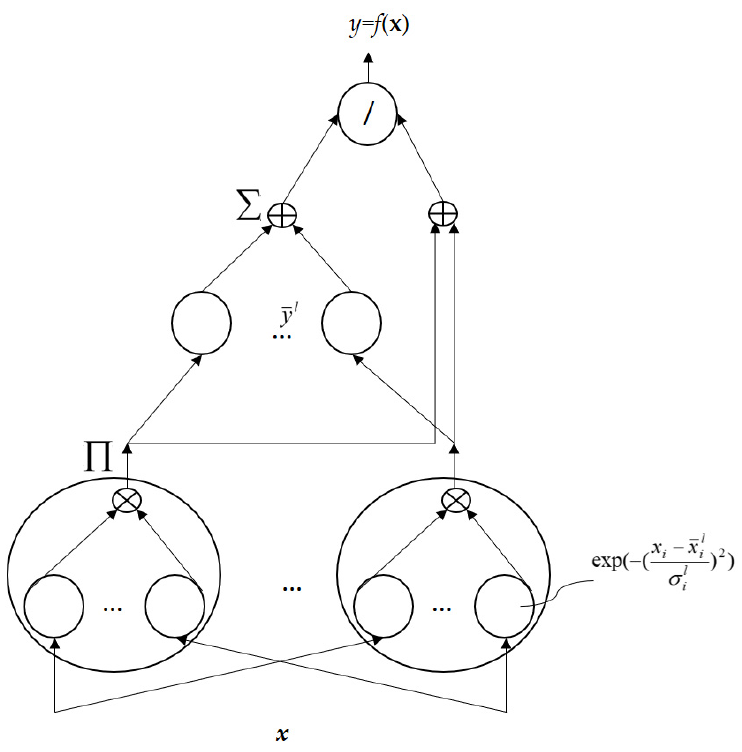
Figure 2. Network representation of the conducted neuro-fuzzy classification.